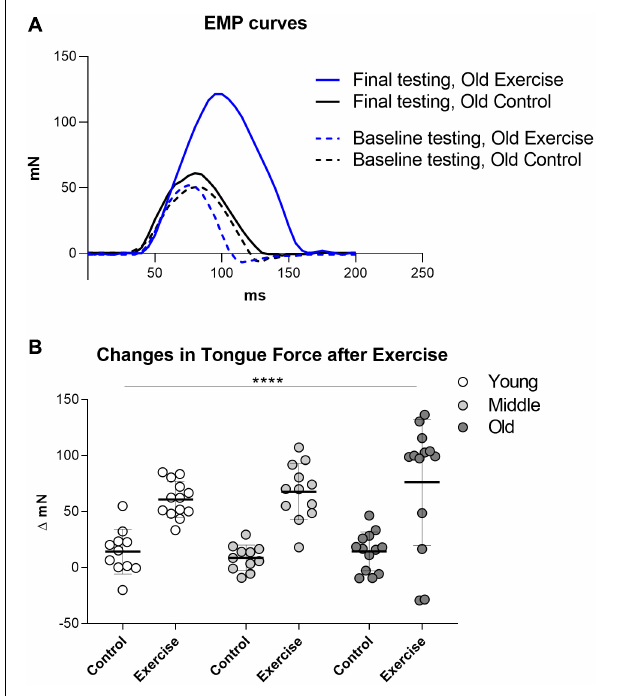
FIGURE 1 | Change in EMP (Estimated Maximum Press) before and after exercise regimen. (A) Examples of tongue press force curves before and after tongue exercise in one old control rat and one old exercise rat. (B) Quantification of changes in Estimated Maximum Press (EMP) forces between initial and final tongue press testing. Results were significant for exercise condition, but not for age. Each symbol indicates data for one rat. Plots indicate group means and SD. Group sizes: Young Adult Control = 11, Young Adult Exercise = 13, Middle Aged Control = 11, Middle Exercise = 12, Old Aged Control = 13, Old Aged Exercise = 13. **** = P <